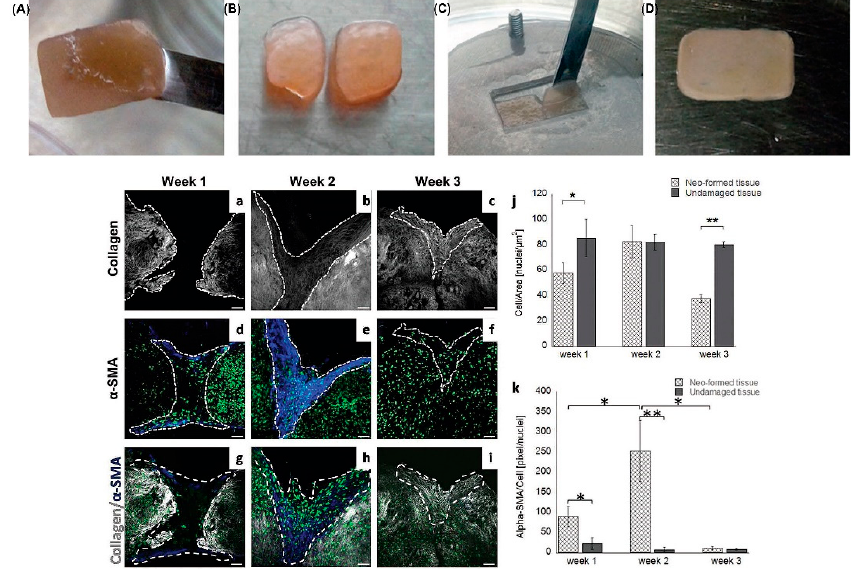
Figure 4. Damaged 3D endogenous dermis equivalent: ( A – D ) Workflow of the 3D-HDE (human dermal equivalent) cutting. Specifically, after 4 weeks of maturation, a 3D-HDE is cut with a scalpel into two parts; then, these parts are reallocated close together in a maturation chamber to reproduce a first intention wound healing in a dynamic regime. ( a – c ) SHG of the 3D-HDE after wounding over 3 weeks illustrates the neoformation of collagen fibers, ( d – f ) Qualitative evaluation of an α -SMA expression, over 3 weeks from wounding, shows how this protein is abundant during the second week which approximately corresponds to the proliferation phase, as the in vivo counterpart. This starting, ( g – i ) Merge of the signals previously described, ( j , k ) Quantitative analyses of the number differences with p < 0.05. Reprinted from Lombardi B, Casale C, Imparato G, et al. Spatiotemporal